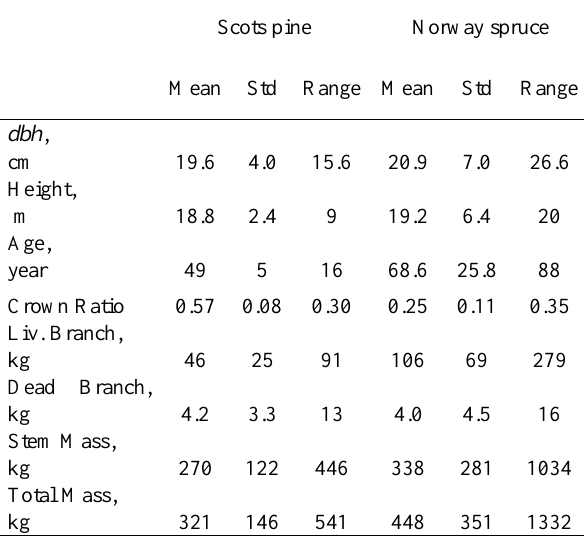
Table 1: Description of sample trees